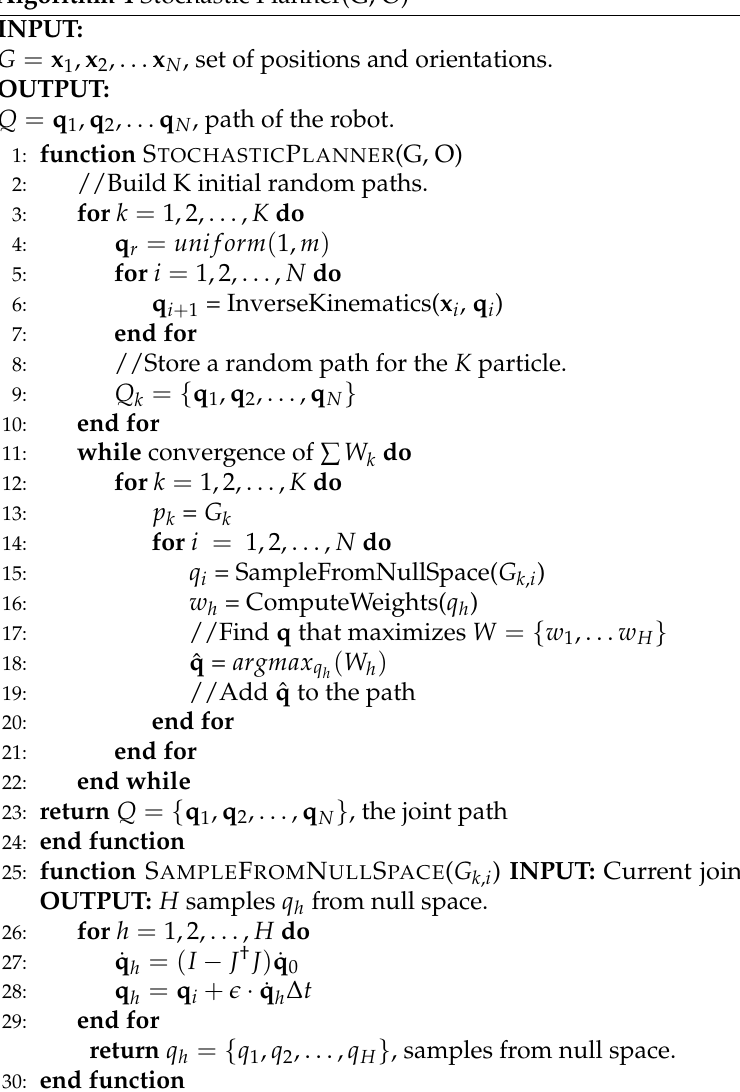
Algorithm 4 Stochastic Planner(G,